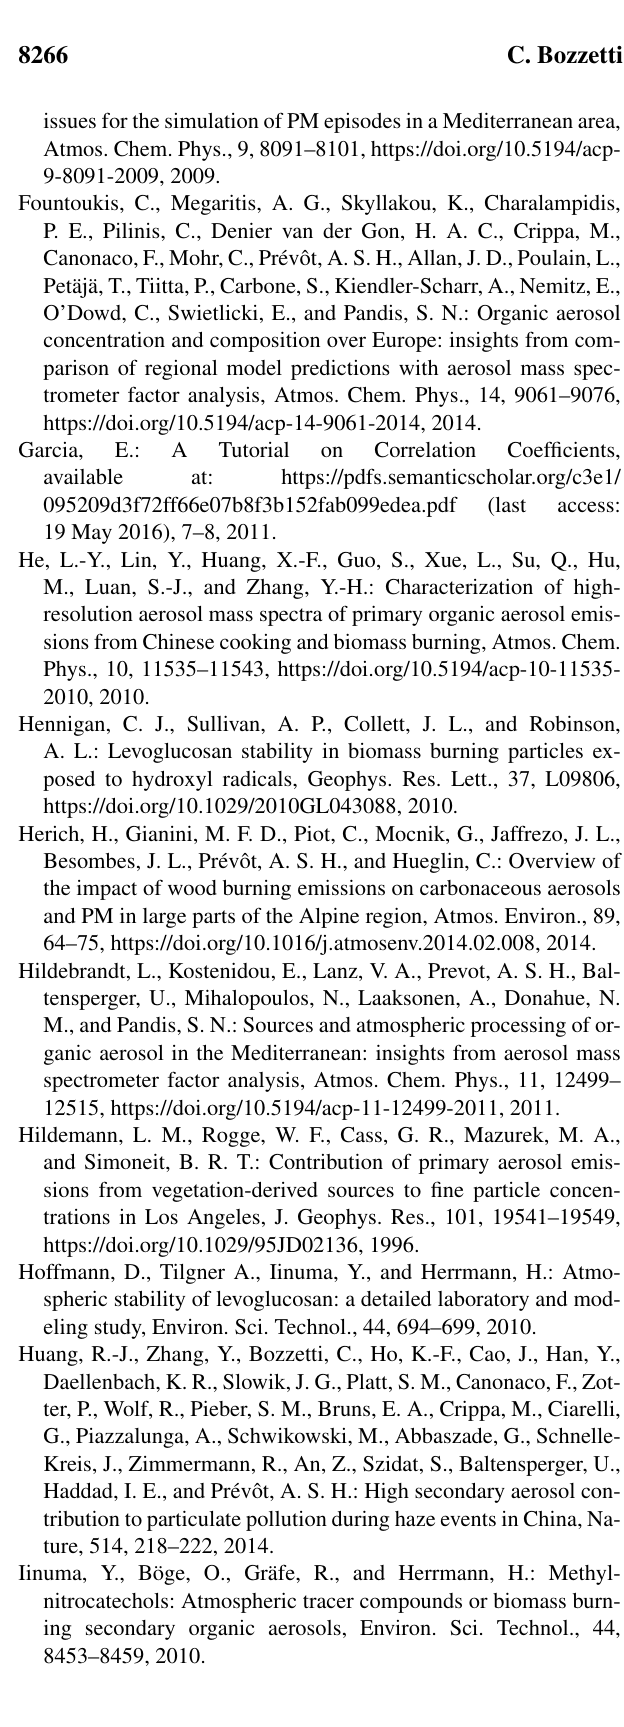
Extended Data Figure 2: Increase in mortality linked to